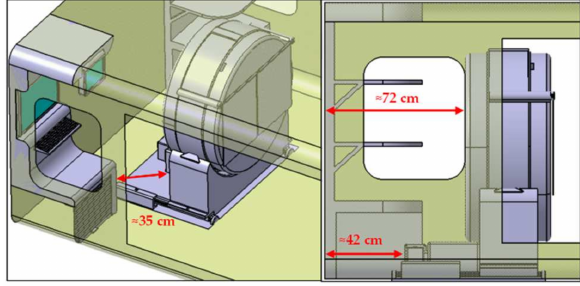
Figure 15. Maintenance